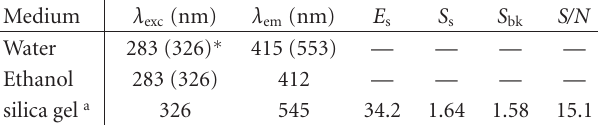
Table 1: Spectrofluorimetric and chromatographic characteristics of